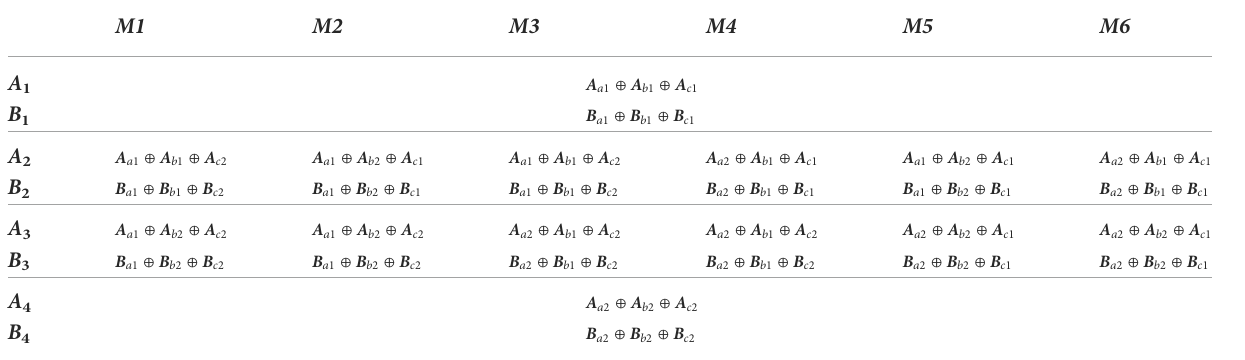
TABLE 1 State matrices of six operation